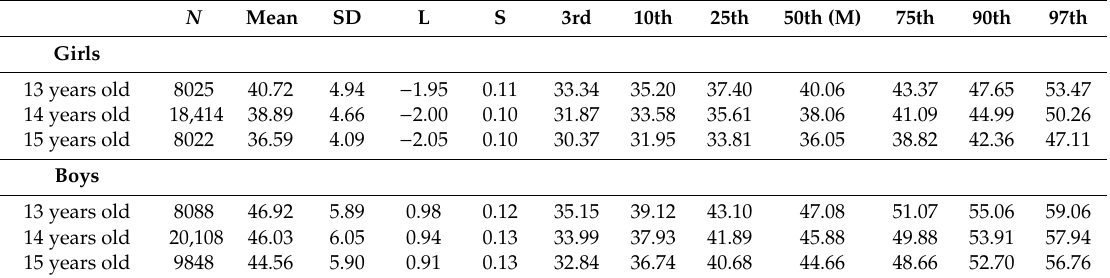
Table 3. Smooth centile scores and Cole’s transformation (L for skewness), median (M), and coe ffi cient . V O 2 peak (20-meter shuttle run test) according to equation of L é ger et al. by of variation (S) values of age and sex